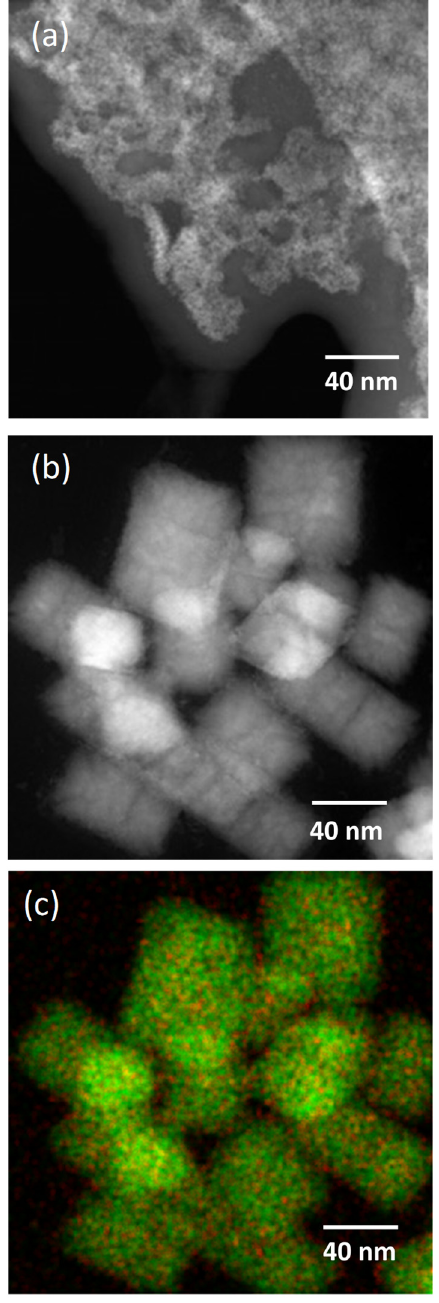
Figure 2. STEM HAADF imaging and EDS mapping of nanoparticles generated by ON: ( a ) HAADF of CeO x and ( b ) HAADF of Eu:CeO x ; ( c ) Ce and Eu L map of the Eu:CeO x NPs (Eu L— red , Ce– green ).